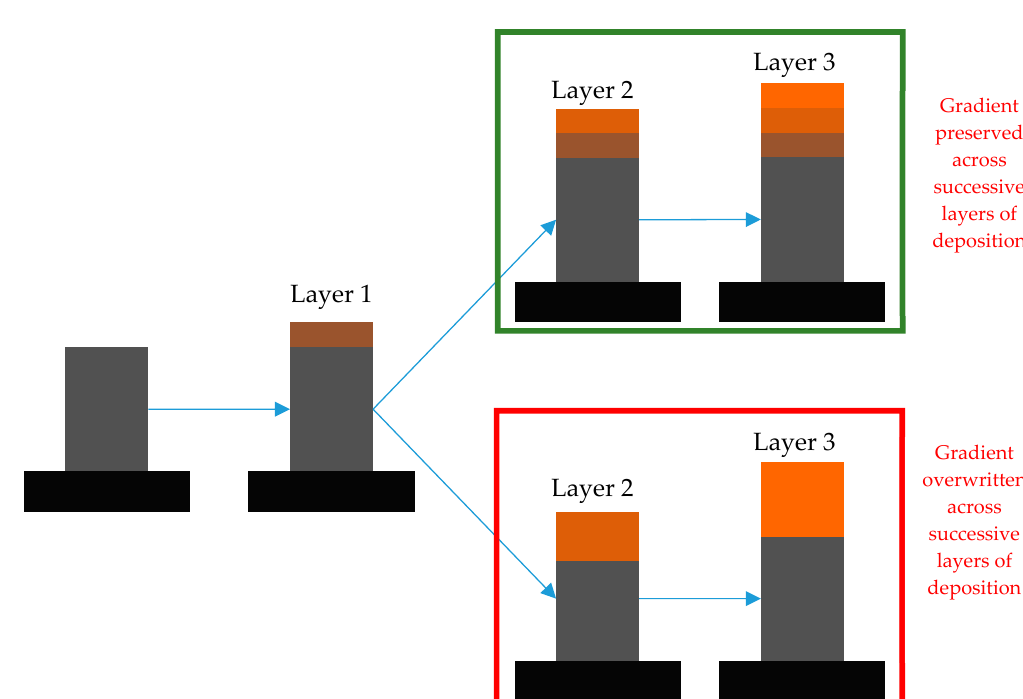
Figure 14. Schematic diagram of transverse sections of FGM deposits detailing the influence of remelting on gradient development during dissimilar material deposition.